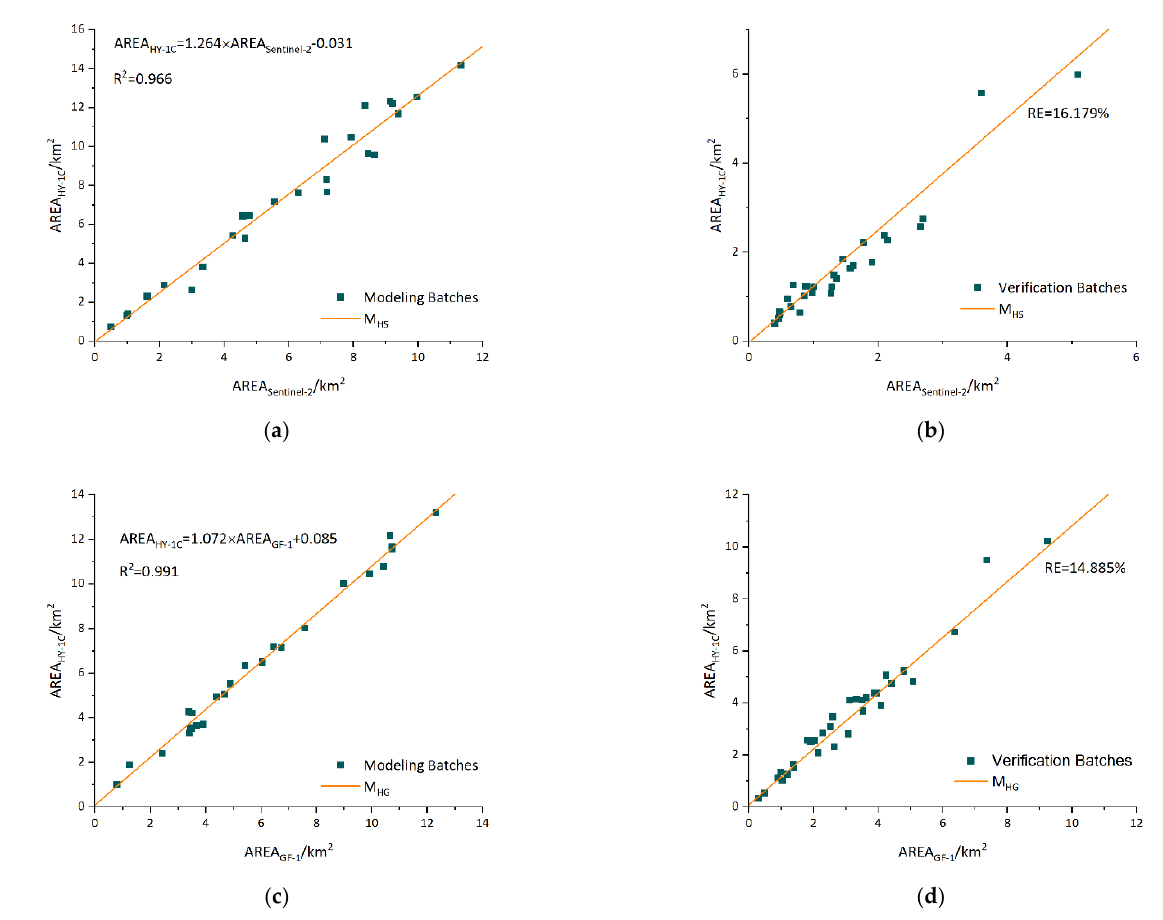
Figure 5. Consistency models and verification. ( a ) Consistency model between HY-1C and Sentinel-2 images. ( b ) Verification result between HY-1C and Sentinel-2 images. ( c ) Consistency model between HY-1C and GF-1 images. ( d ) Verification result between HY-1C and GF-1 images.